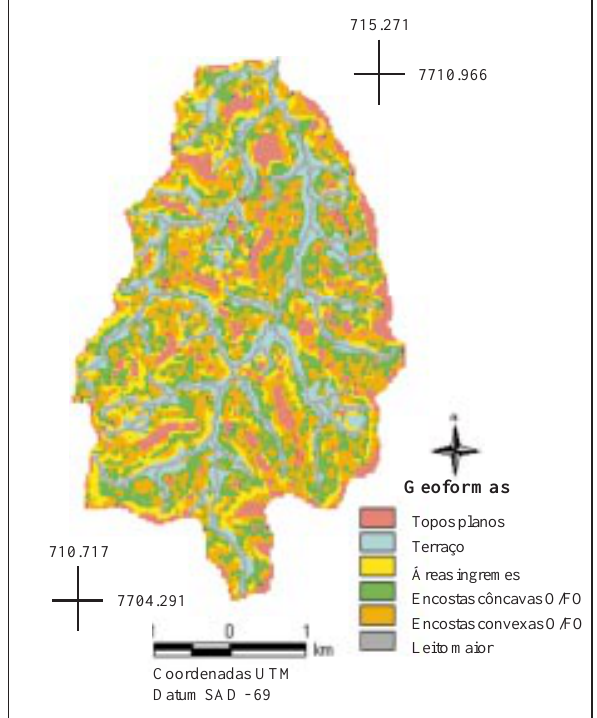
Figura 4. Classificação de geoformas da bacia do Córrego Ipiúna. O/FO: Relevo ondulado e fortemente